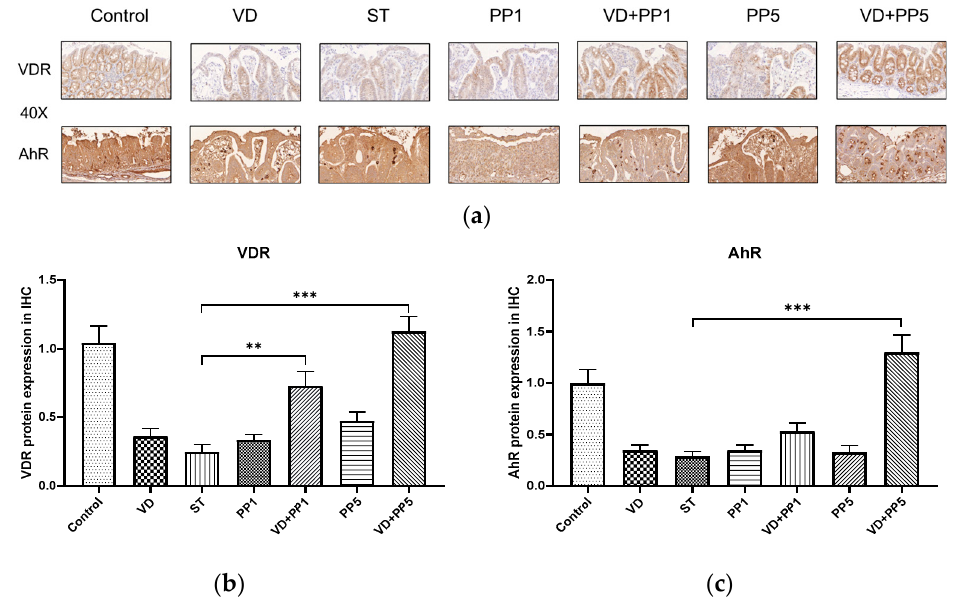
Figure 5. Combination of PP and VD3 synergistically activates the cecal AhR and VDR proteins expression following Salmonella colitis in mice. ( a ) AhR and VDR proteins expression in control, ST, VD, PP1, VD + PP1, PP5, and VD + PP5 groups detected by immunohistochemistry staining (original magnification, ×400; scale bar, 25 μ m; n = 3). The levels of ( b ) VDR and ( c ) AhR immunohistochemistry staining were analyzed and calculated by ImageJ. (** p < 0.01, *** p < 0.001).